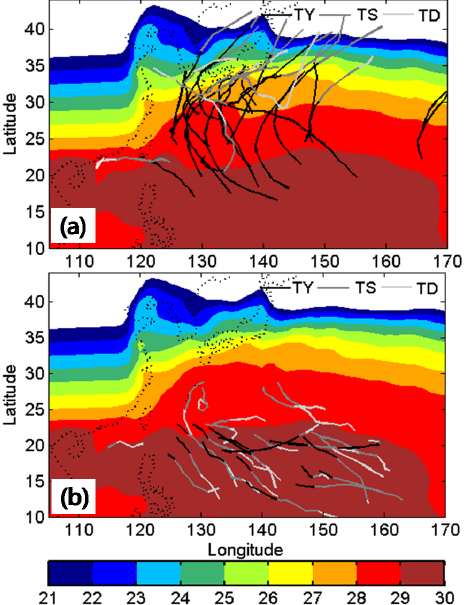
Figure 14. The average SST fields (shading) and TCs tracks (col- orized lines with storm intensity) during their (a) weakening and (b) strengthening